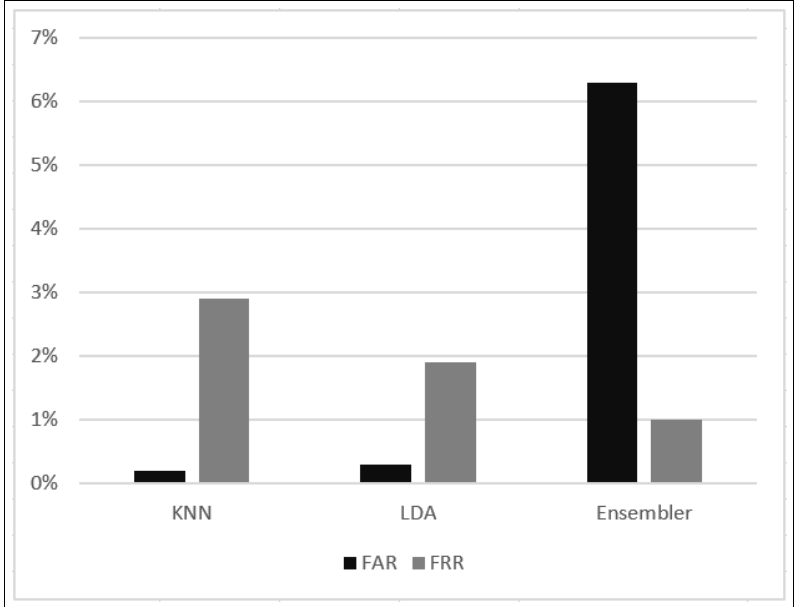
Figure 6. False acceptance rate (FAR) and false rejection rate (FRR) of the three